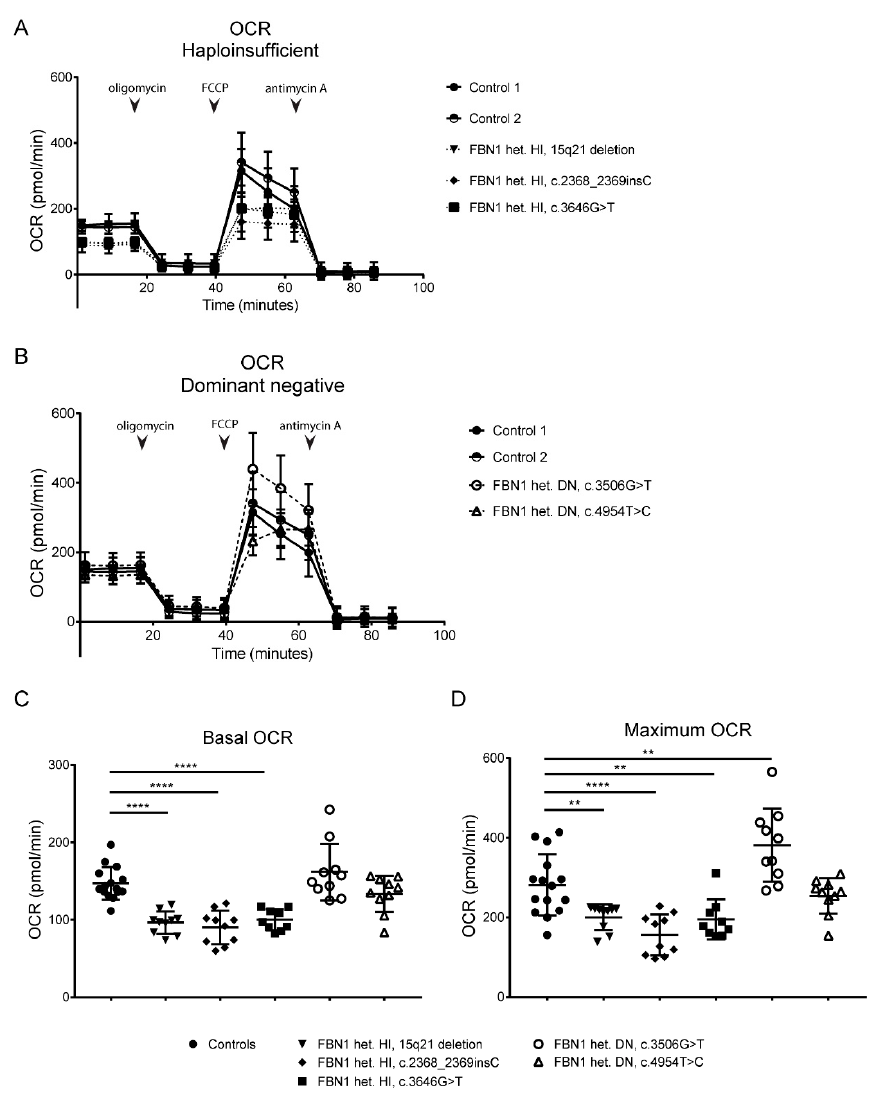
Figure 5. Decreased mitochondrial respiration in FBN1 haploinsufficient VSMCs. ( A ) Oxygen consumption rate (OCR) of FBN1 haploinsufficient (HI) VSMCs at basal level and in response to 1 μ M oligomycin, 1 μ M fluoro-carbonyl cyanide phenylhydrazone (FCCP) and 1 μ M antimycin A. ( B ) Oxygen consumption rate (OCR) of FBN1 dominant negative (DN) VSMCs at basal level and in response to 1 μ M oligomycin, 1 μ M fluoro-carbonyl cyanide phenylhydrazone (FCCP) and 1 μ M antimycin A. Of note, data for controls are depicted twice, in both part A and B. ( C ) Basal OCR of FBN1 mutated VSMCs. ( D ) Maximum OCR of FBN1 mutated VSMCs after addition of 1 μ M FCCP (** p -value < 0.01, **** p -value < 0.0001, Mann-Whitney U test). Results are expressed as mean ± SEM.